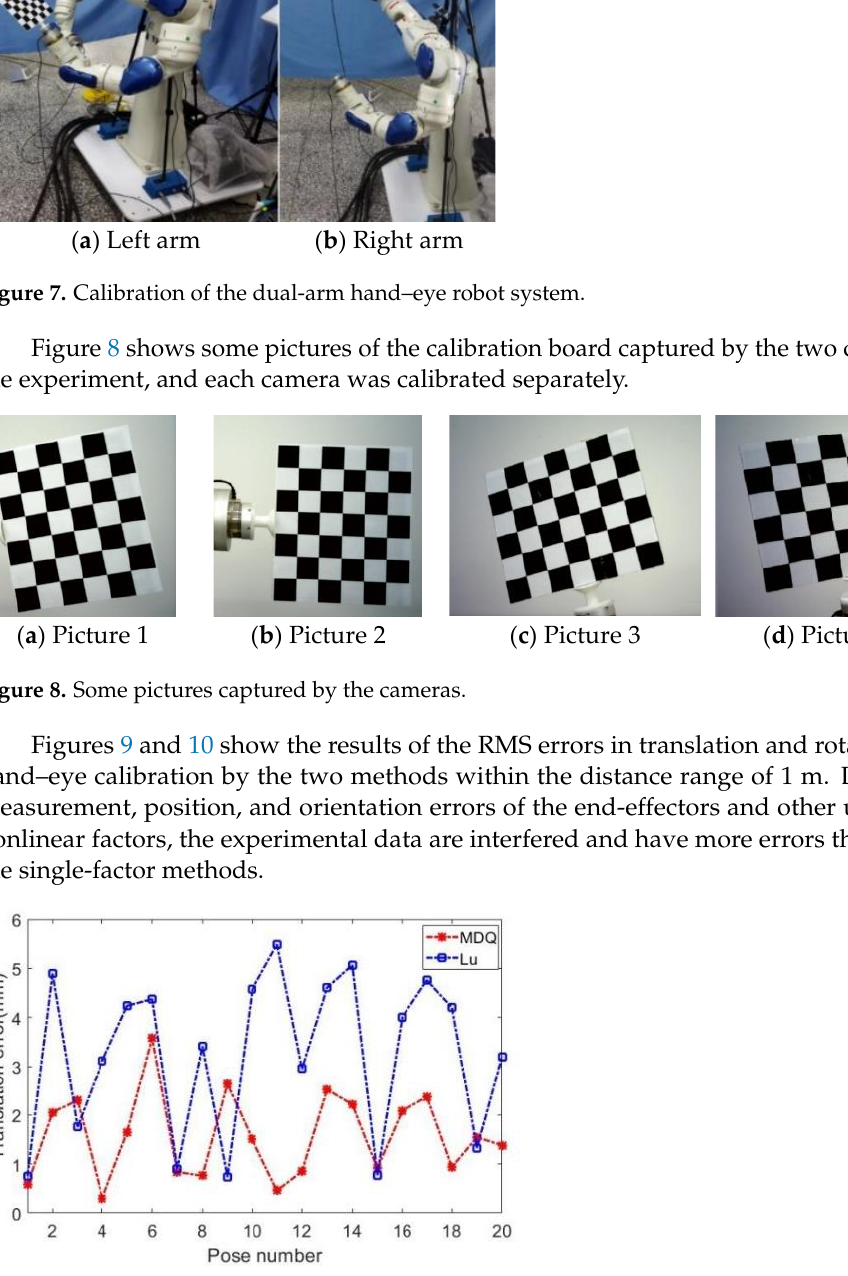
Figure 10. Comparison of the RMS errors in rotation of the calibration results. Otherwise, it can be seen from Figures 9 and 10 that the actual effects are different from the results of the simulation above, but the results are still reasonable. As the scale and unit of the translation are different from the rotation, the threshold ranges of them are also different. It can be seen from the resulting curves in Figures 9 and 10 that the RMS relative errors in translation using MDQ are within 3.7 mm. This means MDQ can obtain better results for translation during the hand – eye calibration in the real experiment. The RMS relative errors in rotation using MDQ are within 0.13 rad. This means MDQ can ob- tain better results for rotation during the hand – eye calibration in the real experiment. Af- ter the steps of the hand – eye calibration for each camera and each arm, the relative pose data of the arbitrary target captured by one camera can be transformed to the other camera